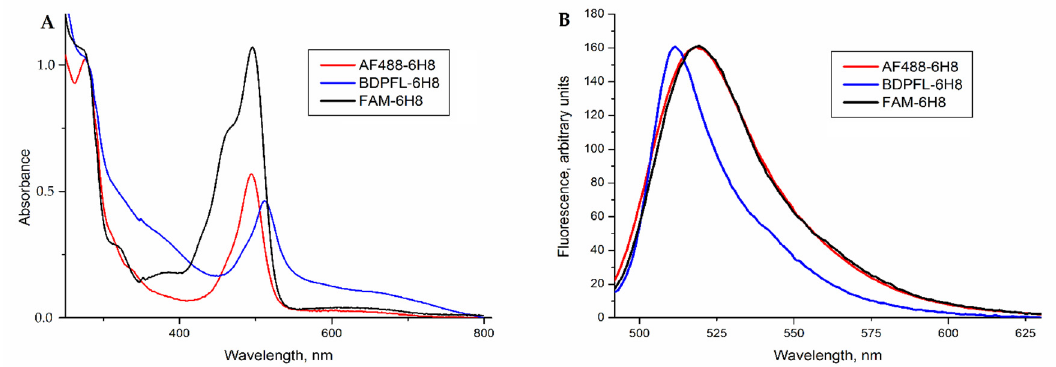
Figure 2. ( A ) Normalized absorption spectra of fluorescently labeled monoclonal antibody 6H8; ( B ) Normalized fluores- cence spectra of fluorescently labeled monoclonal antibody 6H8 ( λ ex = 484 nm).